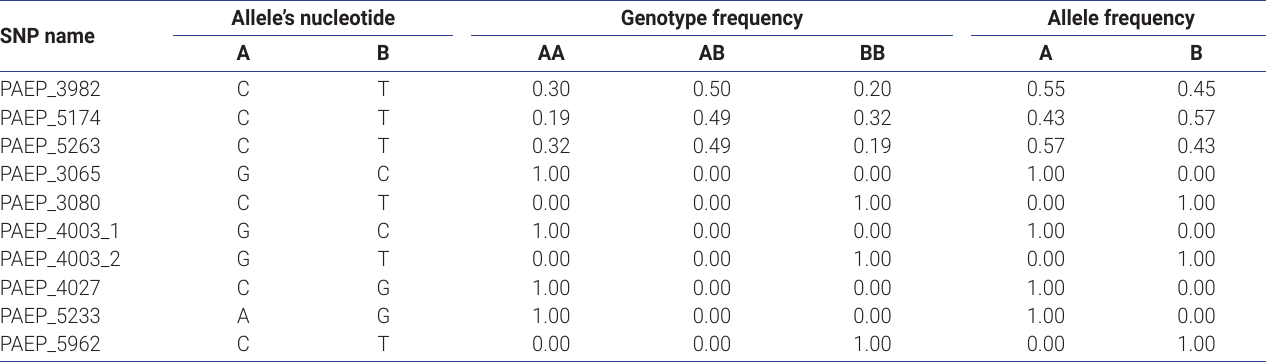
Table 2. Allele and genotype frequency (%) in PAEP